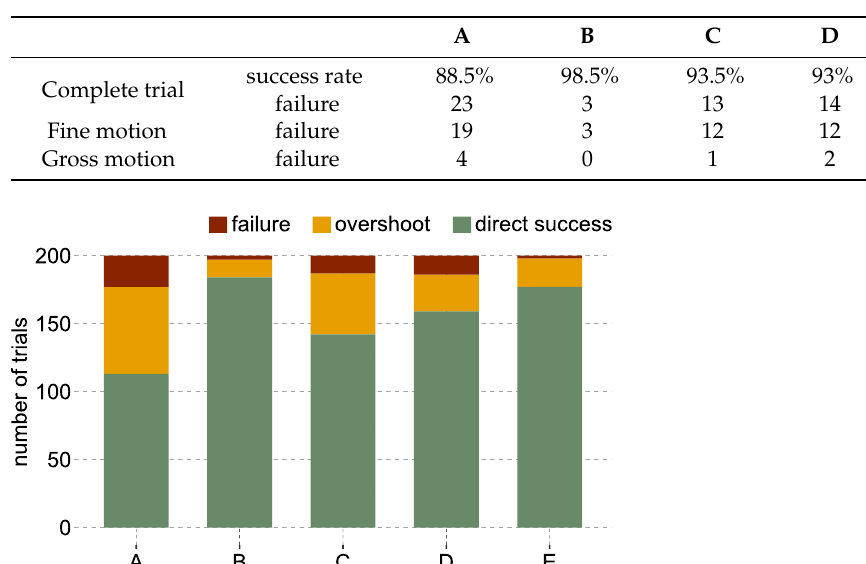
Table 1. Success rates and failures over all subjects during the AT.